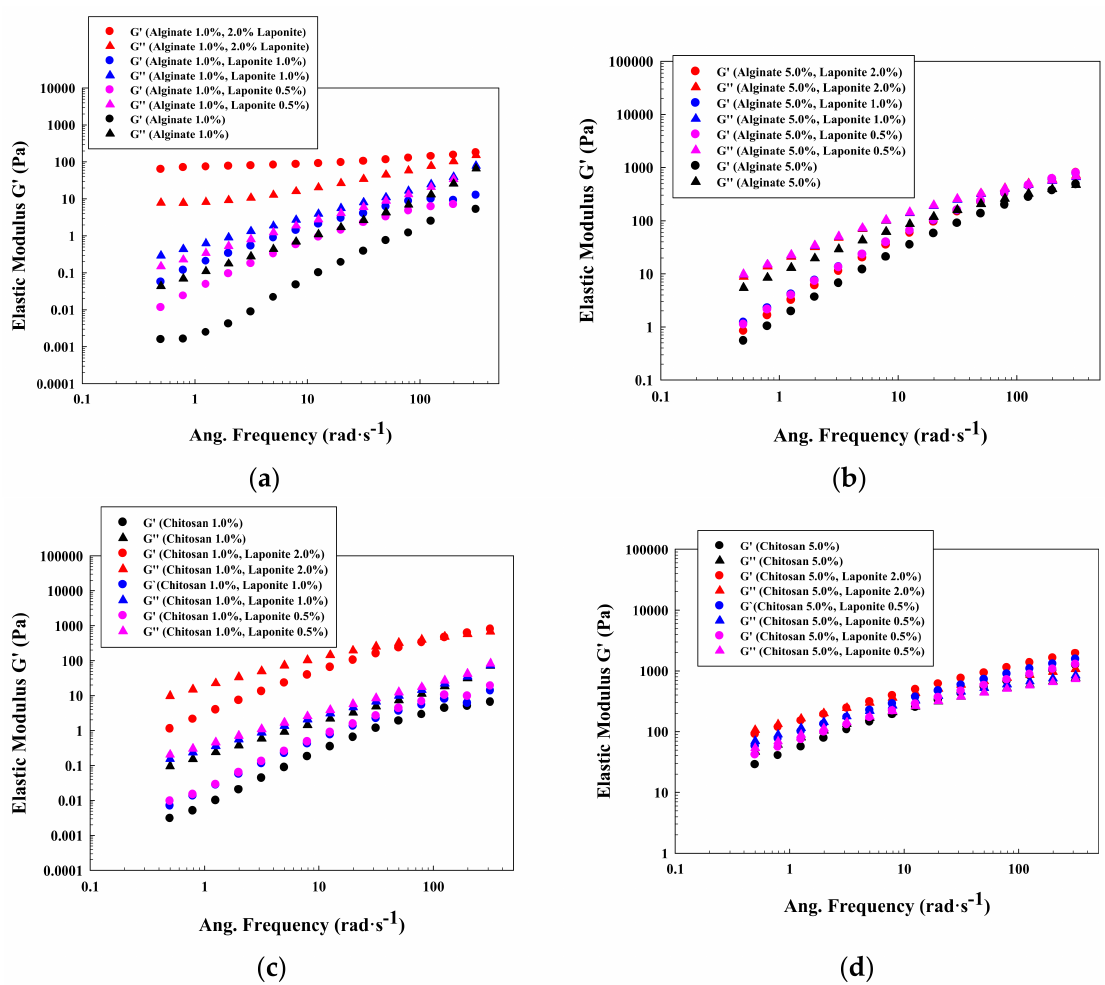
Figure 5. Oscillatory plots for different polysaccharides solutions: ( a ) alginate 1% w / w ; ( b ) alginate 5% w / w ; ( c ) chitosan 1% w / w ; ( d ) chitosan 5% w / w